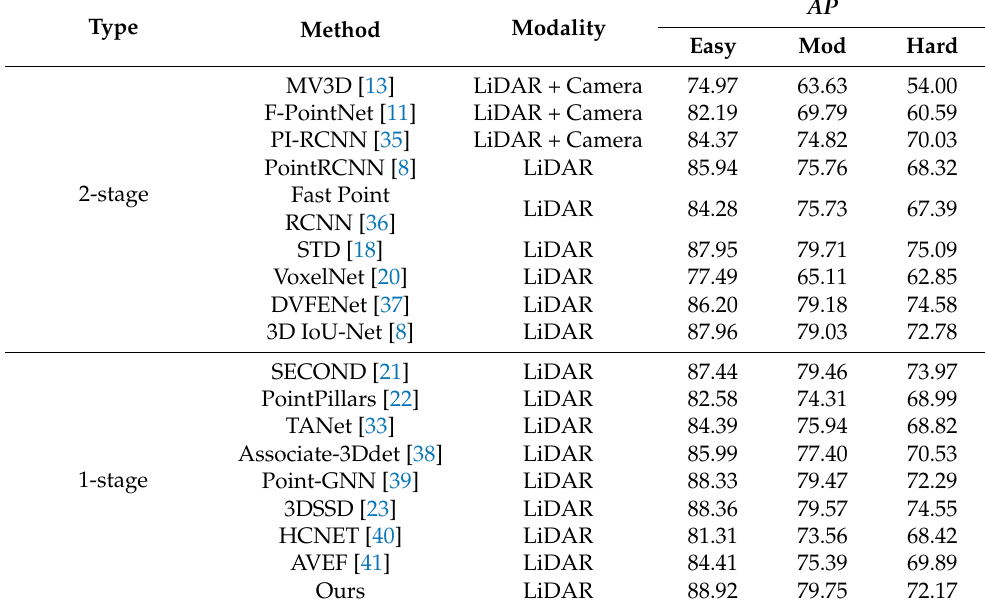
Table 1. Results of the KITTI test set using the car category.